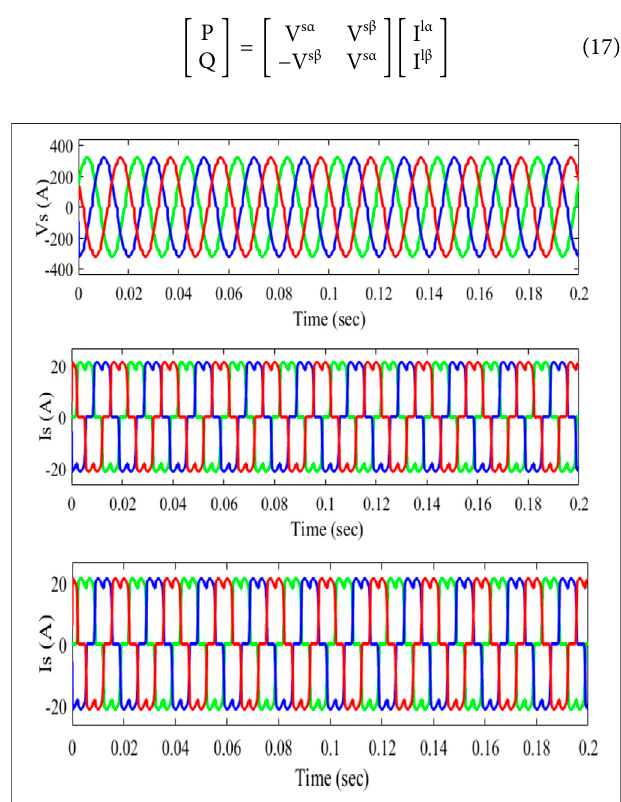
FIGURE 10 | Without the fi lter for nonlinear load source voltage (V s ), source current (I s ), and load current (I L ).